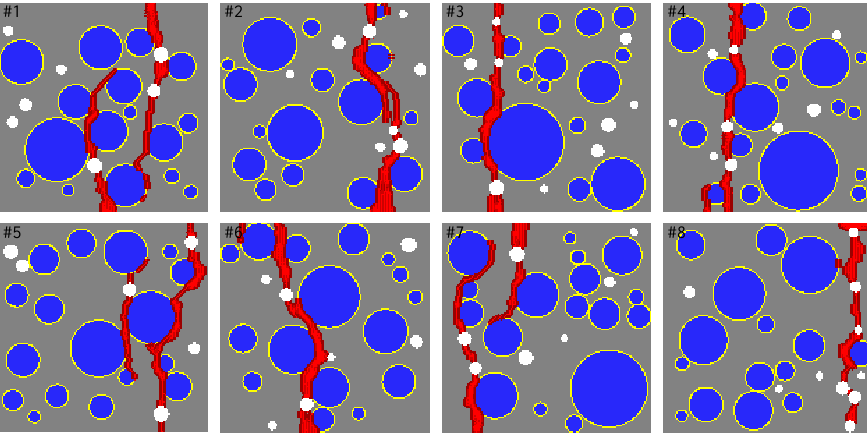
Figure 15. Crack pattern for selected specimens with P pore = 2% and P agg = 20%.